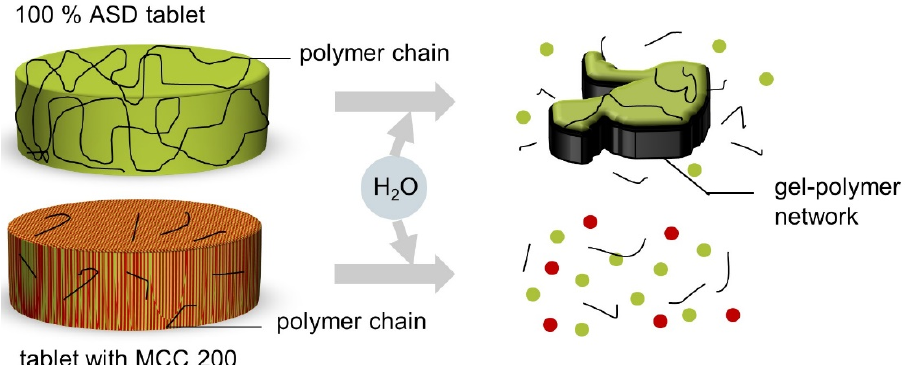
Figure 11. Illustration of the formation of a gel–polymer network in ASD tablets without MCC 200 and in comparison to tablets with MCC 200. Modified from Demuth et al.